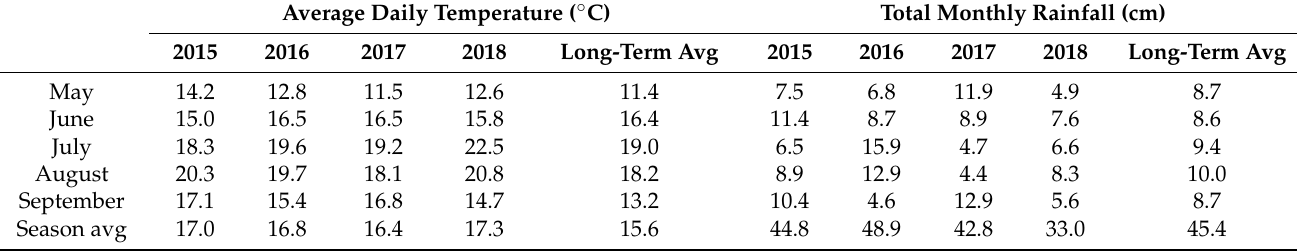
Table 2. Average daily temperature and total monthly rainfall for the months of May through September at the Presque Isle research site for 2015 to 2018 compared with long-term (30-year) average